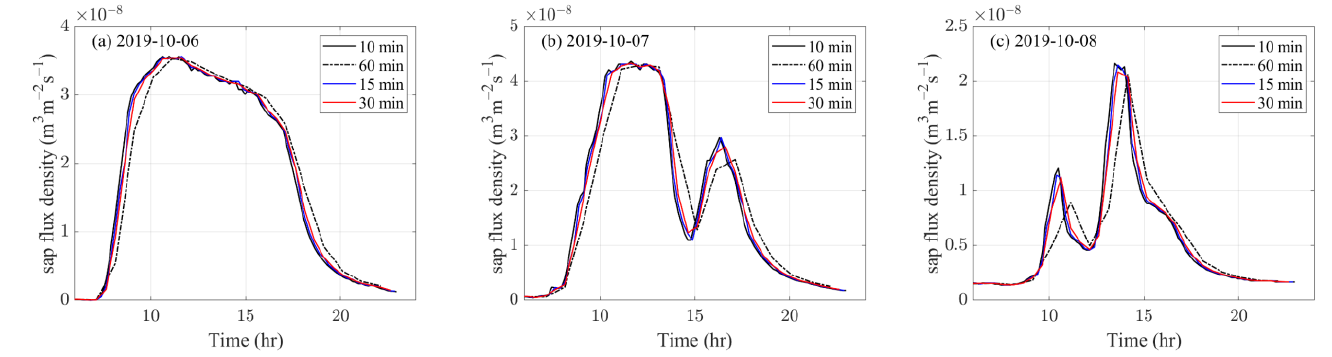
Figure 3. Diurnal variations of sap flux density under different sky conditions. ( a ) clear, ( b ) cloudy, ( c ) overcast.